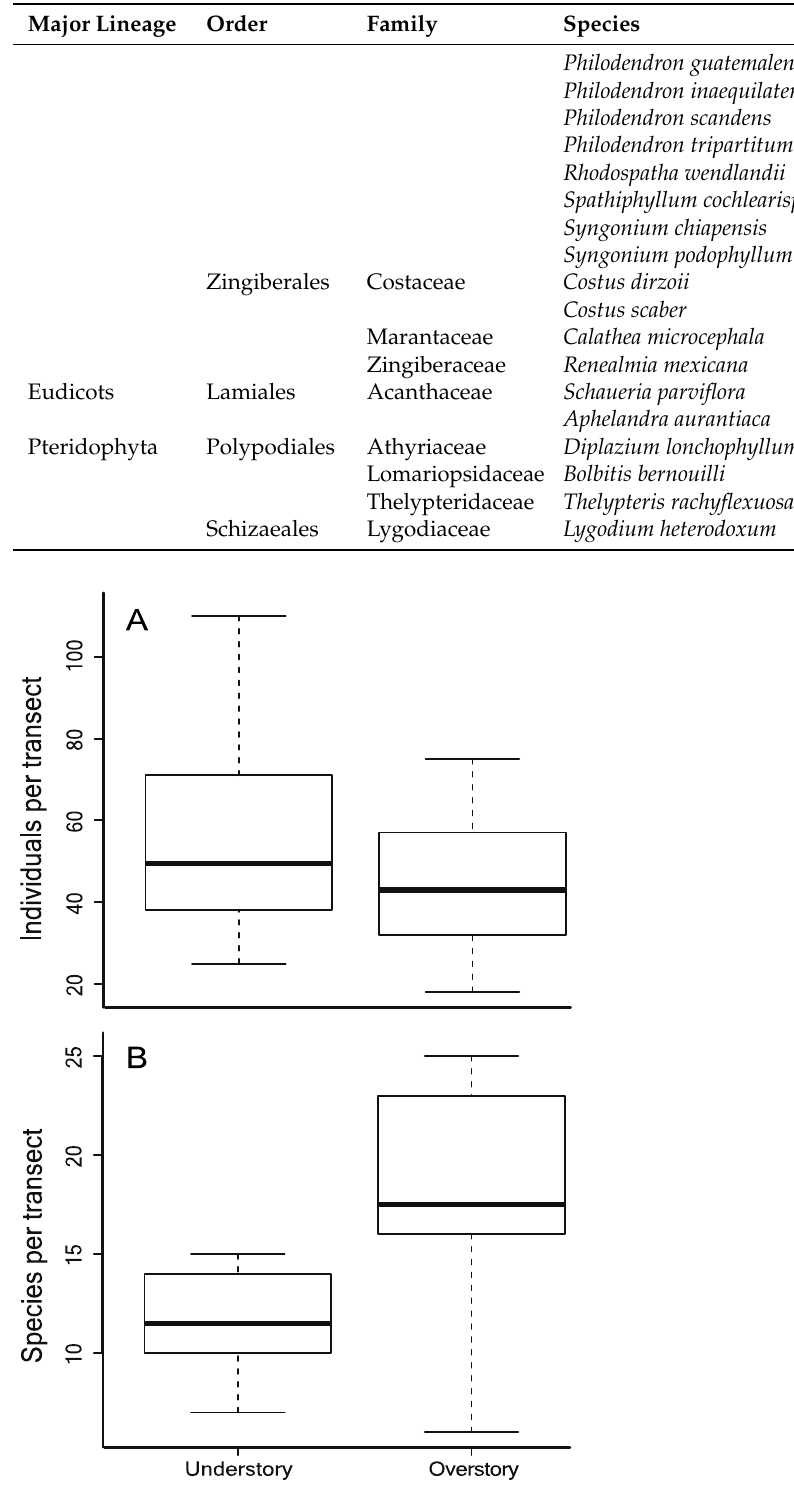
Figure 1. ( A ) Total encounters (intercepts for understory plants and stem number for overstory plants, per 100 m 2 transect). ( B ) Species richness in understory and overstory strata. The overstory plant community (Figure 2) is dominated by a combination of canopy trees, palms, and mid- and low-stratum trees, including, among the 15 most important (IVI value), Nectandra ambigens (canopy), Astrocaryum mexicanum (palm), Brosimum